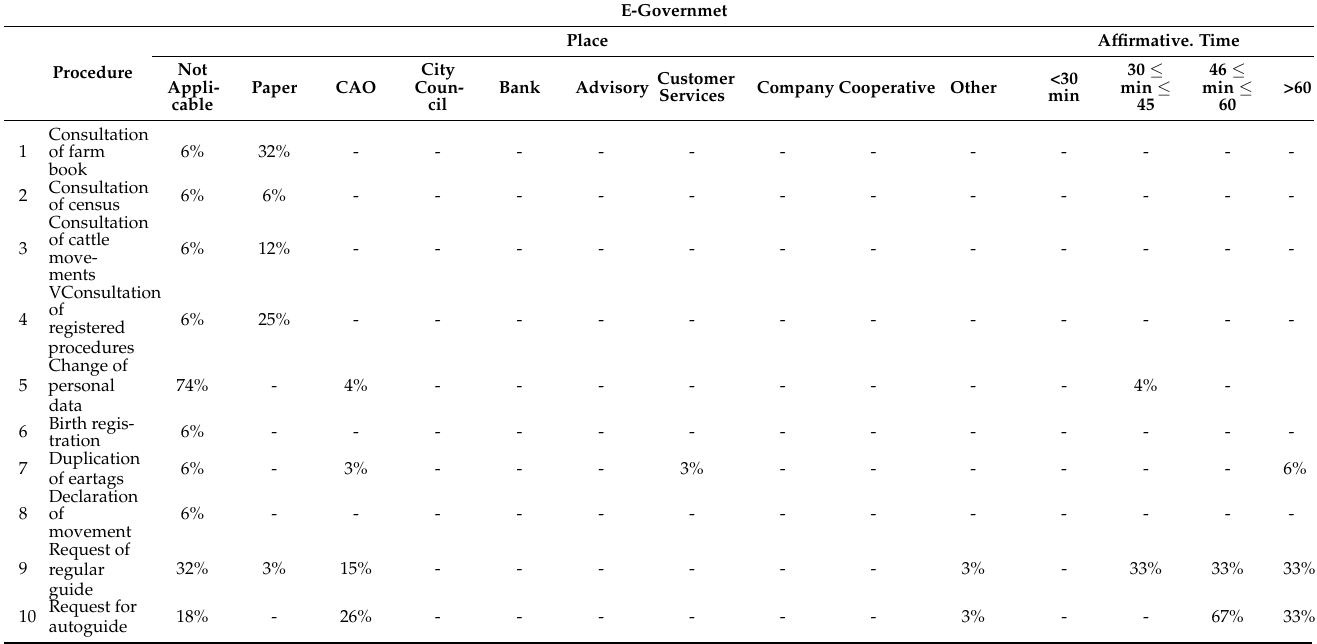
Table 2. Type C Questions. Place where they fulfil them and time they